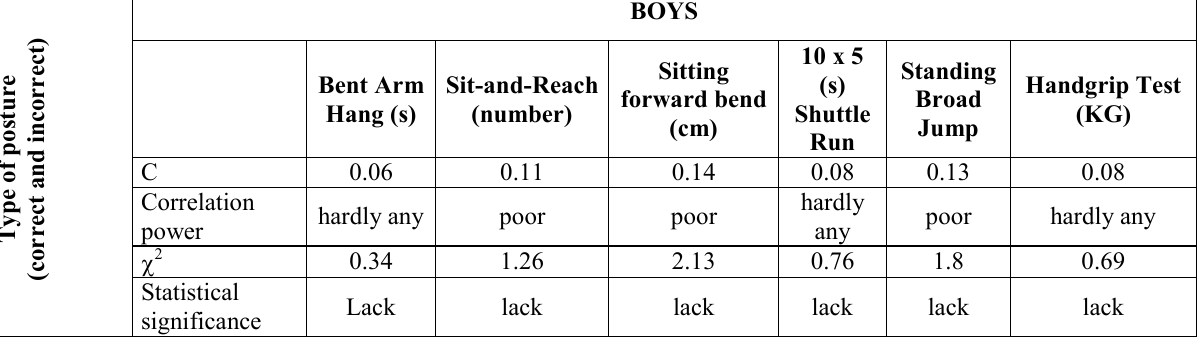
Correlations occurring between the posture (correct and incorrect) and selected tests of the EUROFIT physical fitness test in the boys involved in the study